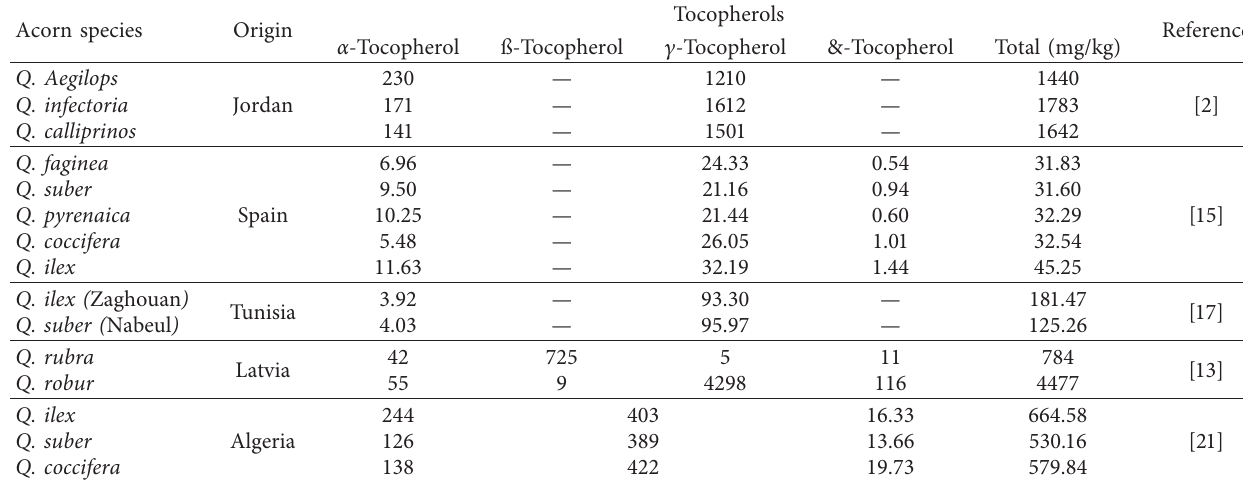
Table 4: Tocopherol homologue content (mg/kg oil) of acorn oils.